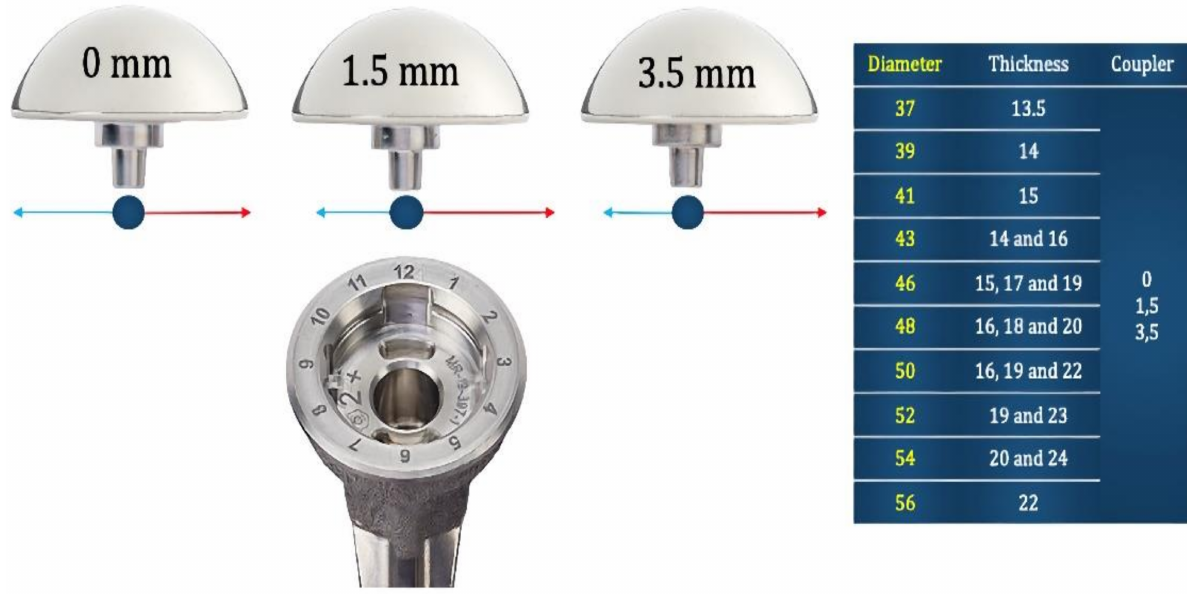
Figure 3. Options for replacement of the humeral head with one system for anatomic shoulder